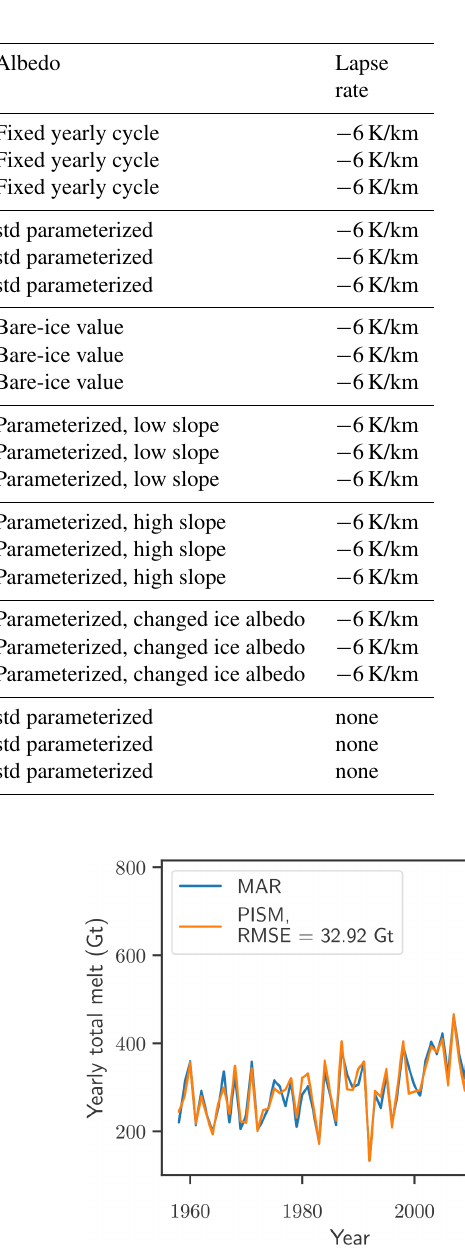
Figure 1. Comparison of annual total melt of the Greenland Ice Sheet as calculated with MAR v3.11 and PISM-dEBM-simple. The diagnostic simulation with PISM-dEBM-simple (orange line) is performed using monthly MAR 2D temperature fields as forc- ing. The albedo α s is parameterized with the local melt rate m as α s = 0 . 82 − 0 . 025yr/m · m , and the shortwave downward radi- ation is approximated by the top-of-the-atmosphere radiation and the transmissivity τ A parameterized with surface altitude z as τ A = 0 . 037km − 1 · z + 0 . 57. The root-mean-square difference between the PISM-dEBM-simple simulation and total melt as given by MAR (blue line) is